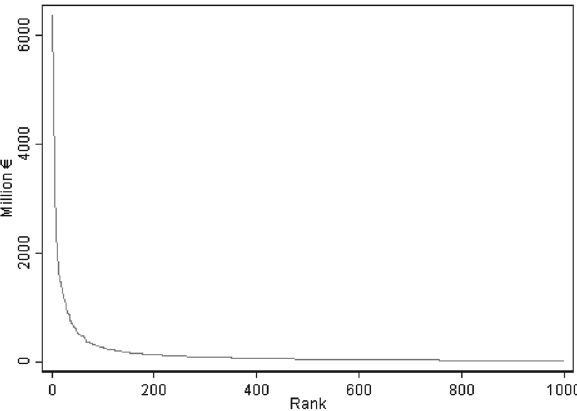
Fig. 1 The distribution of exports in the top 1000 firms, 2015. Source: Own calculations, based on the Customs database